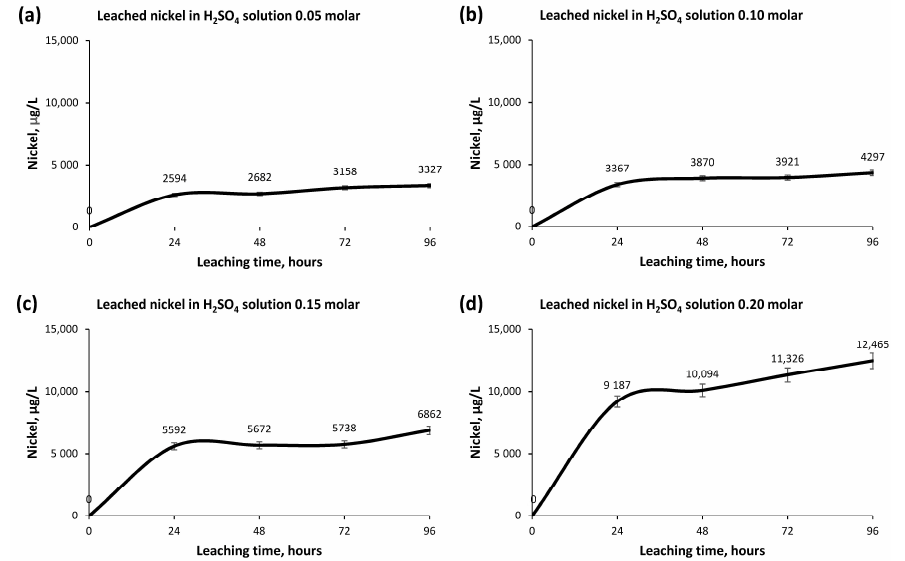
Figure 9. Analysis of the Nickel concentration in the leaching process at atmospheric pressure, ambient temperature and in di ff erent Sulphuric Acid solutions: ( a ) 0.05 molar H 2 SO 4 solution, ( b ) 0.10 molar H 2 SO 4 solution, ( c ) 0.15 molar H 2 SO 4 solution and ( d ) 0.20 molar H 2 SO 4